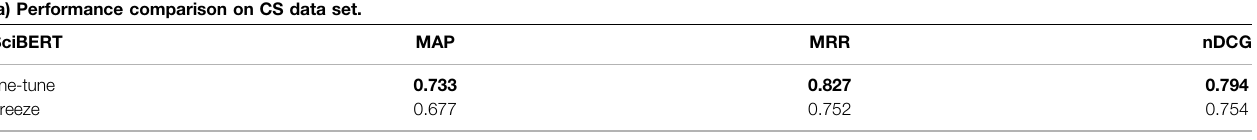
TABLE 7 | Evaluation of the effect of fi ne-tuning of SciBERT model on CS papers. (a) Performance comparison on CS data set.